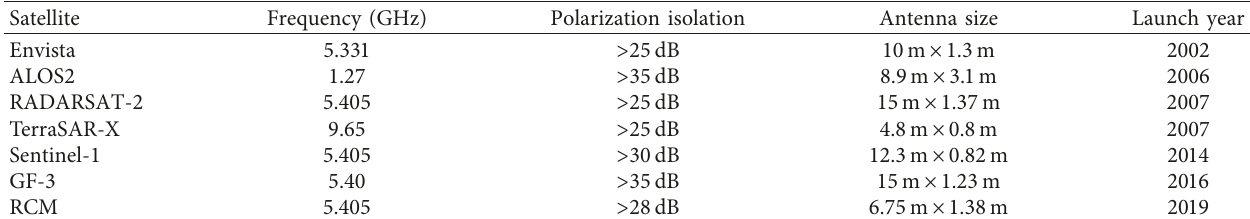
Table 1: Characteristics comparison of SAR antennas between PolSAR